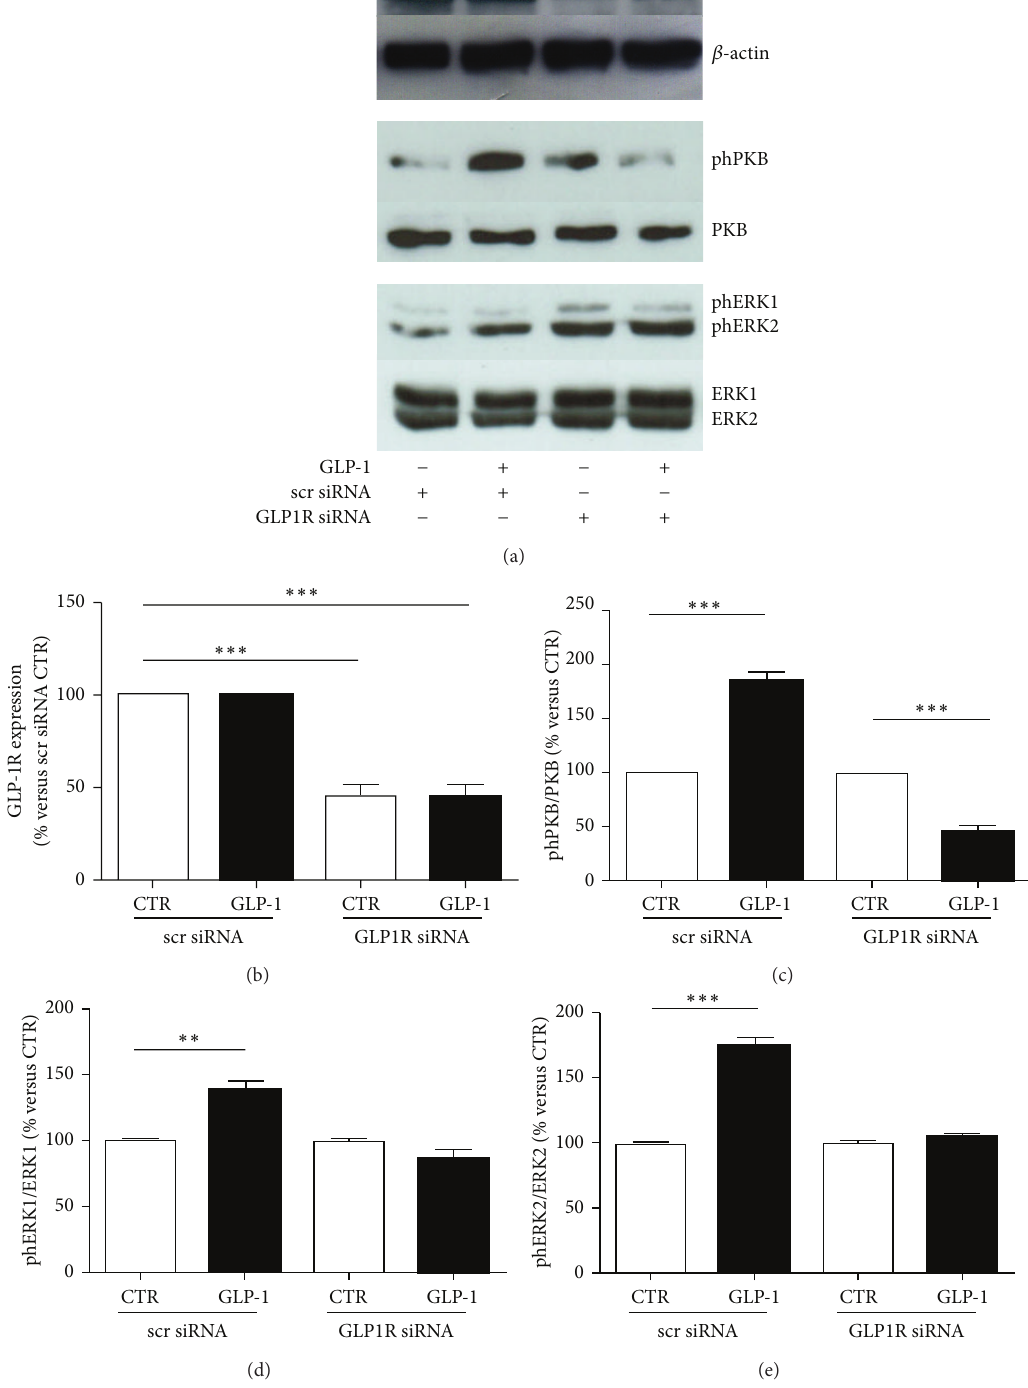
Figure 4: GLP-1R silencing abrogates GLP-1-induced signalling pathway activation. ARPE-19 cells were transfected with scrambled (scr) siRNA control or GLP-1R siRNA and treated with 10nmol/L GLP-1 for 10 minutes. Cells were then lysed and tested with antibody anti- GLP-1R, anti-phPKB, or anti-phERK1/2. Membranes were stripped and reprobed, respectively, with anti- 𝛽 actin, anti-PKB, or